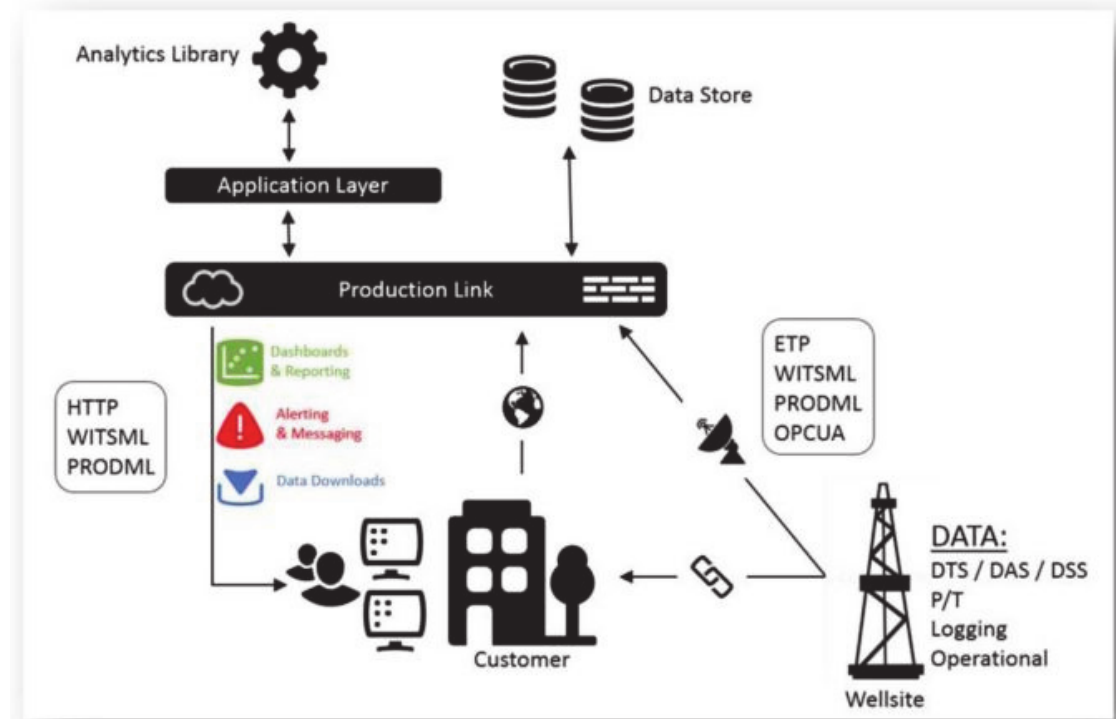
Figure 5. Data communication and flow between field device, cloud server, and customer